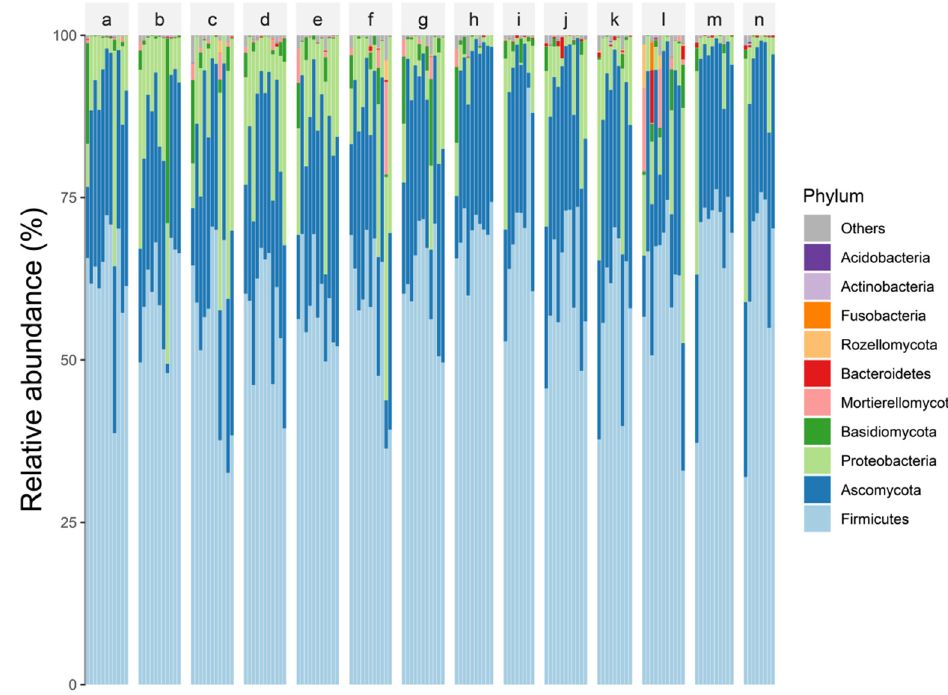
Figure 3. Histogram of dominant phylum stacking. A–n are the treatment group numbers and the top 10 phyla in terms of relative abundance of fungi and bacteria are shown. a–n is the id of each experimental group of Figure 2.